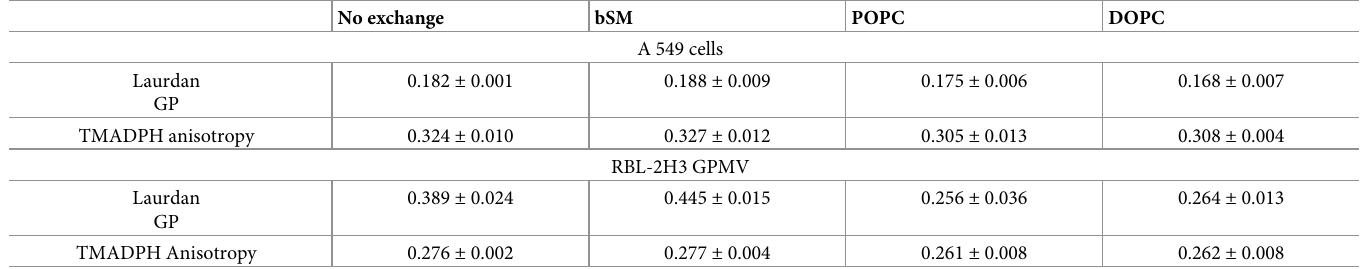
Table 1. Effect of lipid exchange with SM or PC on membrane physical properties. No exchange bSM POPC